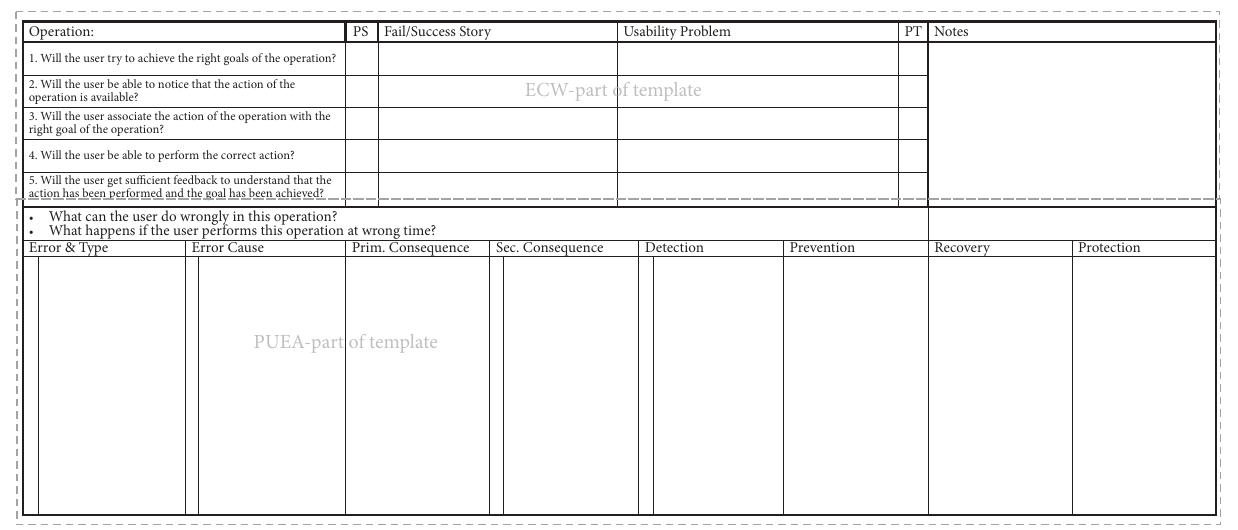
Figure 2: Template for operation level analysis for the conjoint use of ECW and